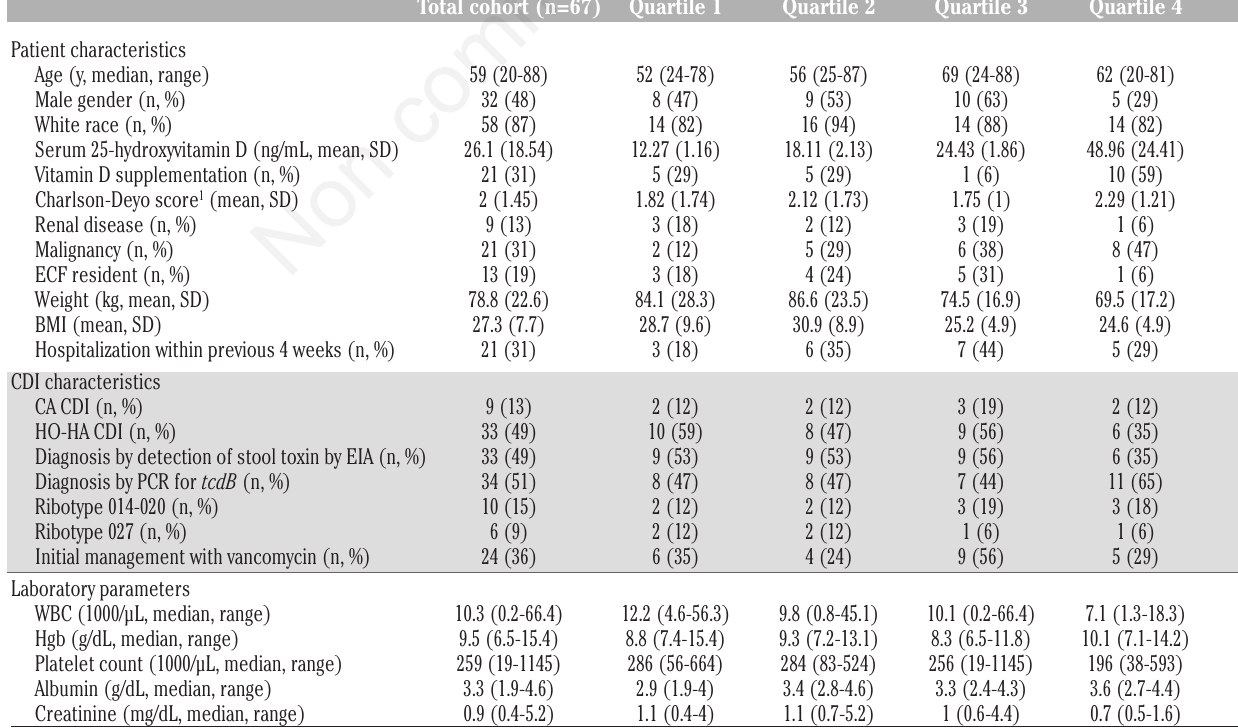
Table 1. Baseline patient demographics, C. difficle characteristics, and laboratory markers at diagnosis for the overall cohort and quar- tiles of increasing serum 25-hydroxyvitamin D